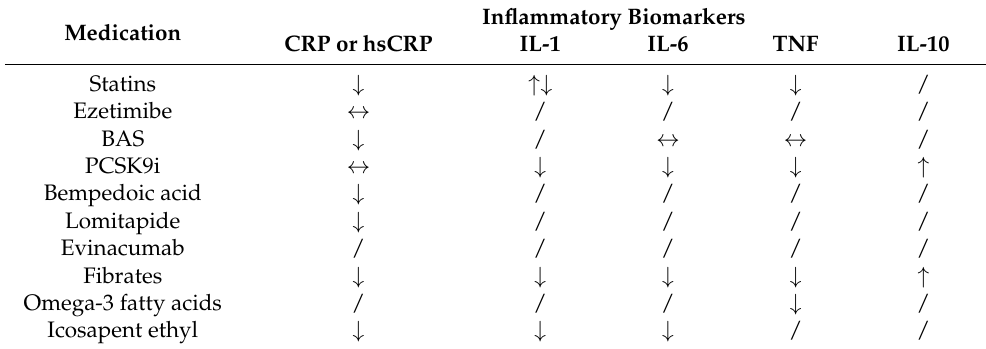
Table 1. Impact of lipid-lowering drugs on selected inflammatory